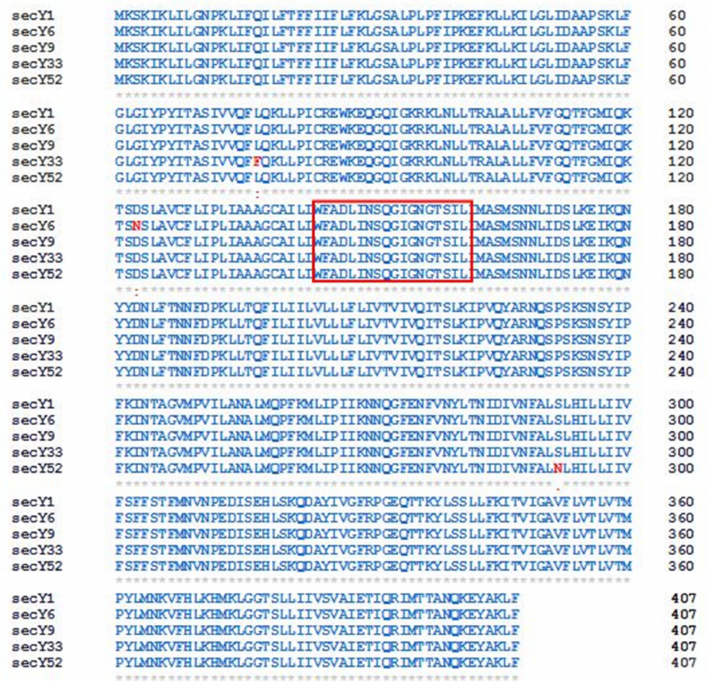
Figure 4. Sequence alignment of SecY protein variants identified in the present study. Red colored box indicates the SecY signature [39]. Identical residues ‘*’; conserved substitutions (similarity > 70%) ‘:’; semi-conserved substitutions (35–70% similarity) ‘.’. Numbers indicate amino acid